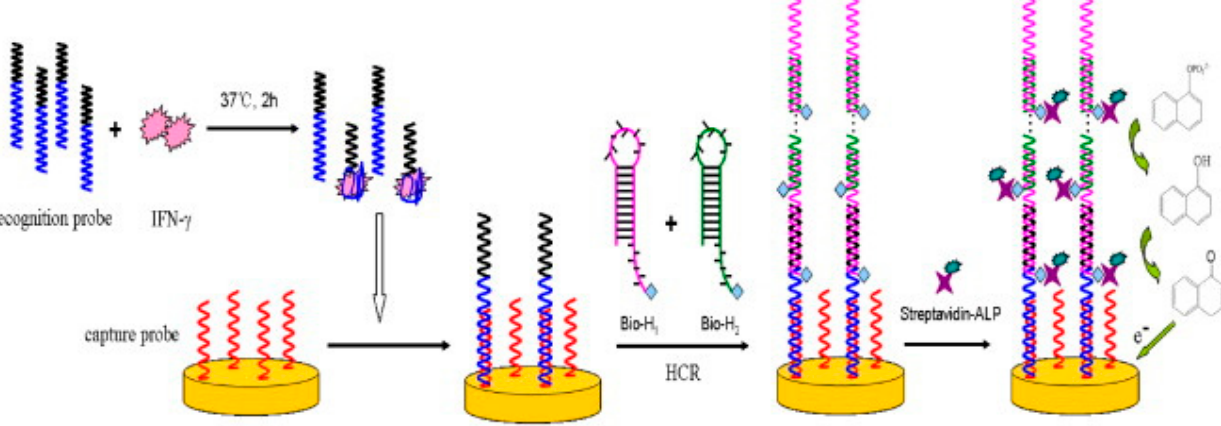
Figure 4. Schematic illustration of an electrochemical DNA biosensor for IFN γ based on hybridization chain reaction with enzyme ‐ amplification. IFN γ partly quenches the recognition probes, while unbound recognition probes hybridize with the capture probes, followed by successive hybridization with biotinylated DNA hairpins. Tagged ALP dephosphorylates 1 ‐ NPP, which is further oxidized to 1 ‐ NP. Reprinted from [108] with permission from Elsevier.